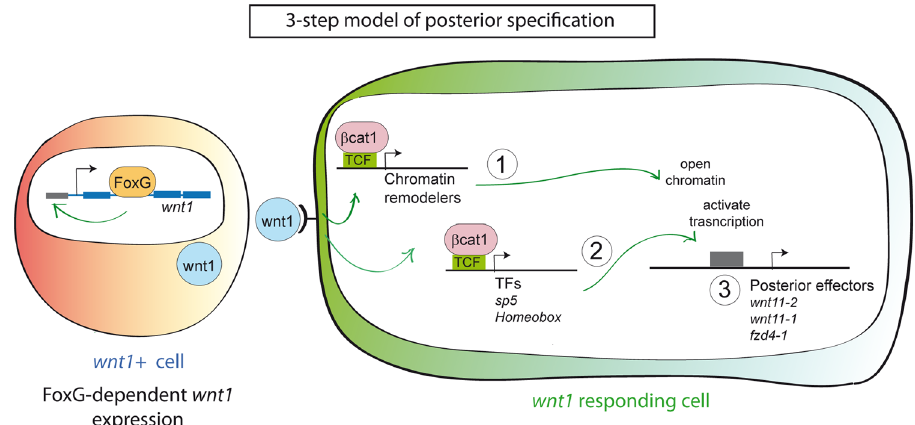
Fig.6|Three-stepmodelofposteriorspeci fi cation. Ourdatasupportsaworking model in which after an amputation, foxG is expressed at early stages of regen- eration in the posterior-facing wounds. The FOXG transcription factor activates wnt1 expression in the organizer cells, possibly by interacting with an enhancer located inits fi rst intron. Because of thisinteraction, these cellsexpressand secret